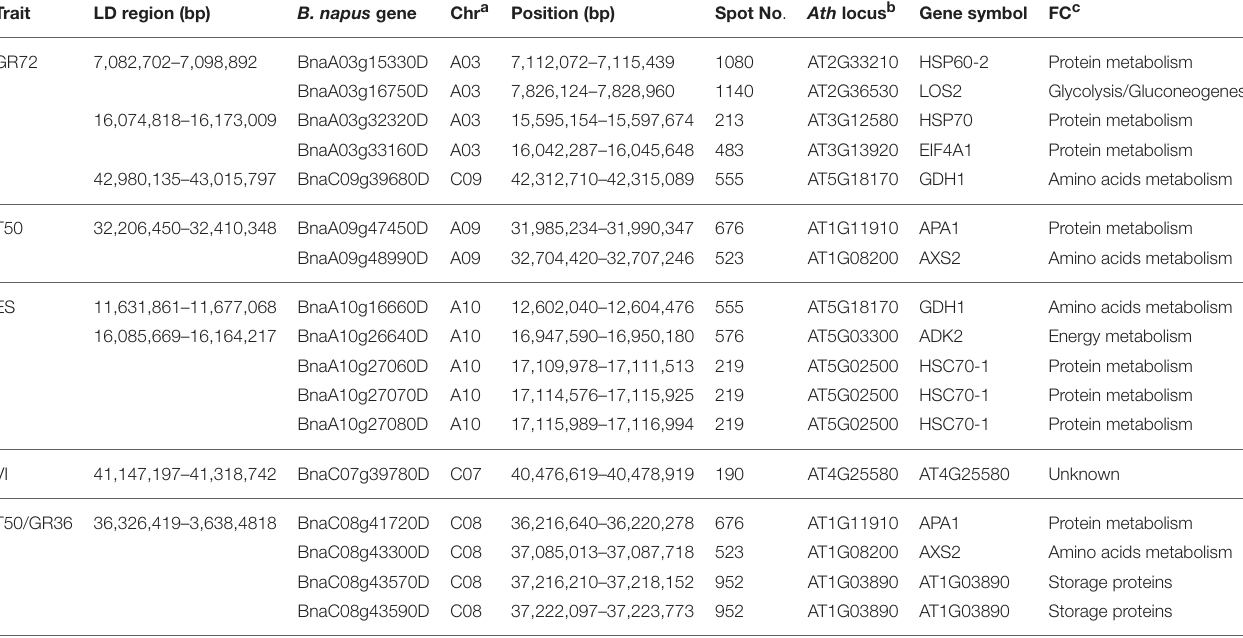
TABLE 3 | DEPs verified within and near associated LD regions in seed germination and vigor-related genome-wide association mapping. Trait